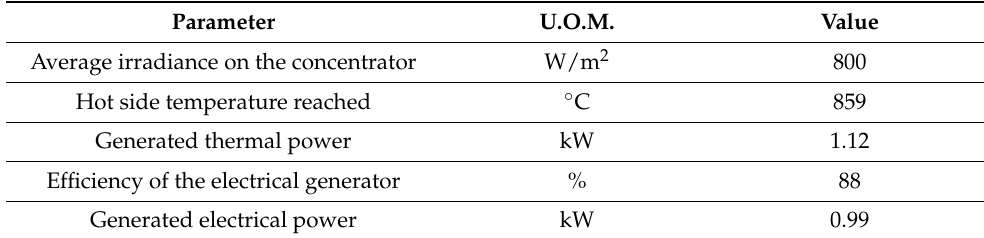
Table 8. Results of the simulation. Parameter U.O.M. Value Average irradiance on the concentrator W/m 2 800 Hot side temperature reached ◦ C 859 Generated thermal power kW 1.12 Efficiency of the electrical generator % 88 Generated electrical power kW